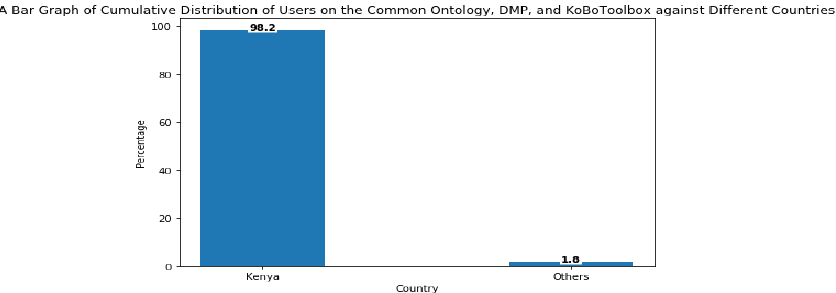
Figure 10. REDCap—percentage distribution of users by country.